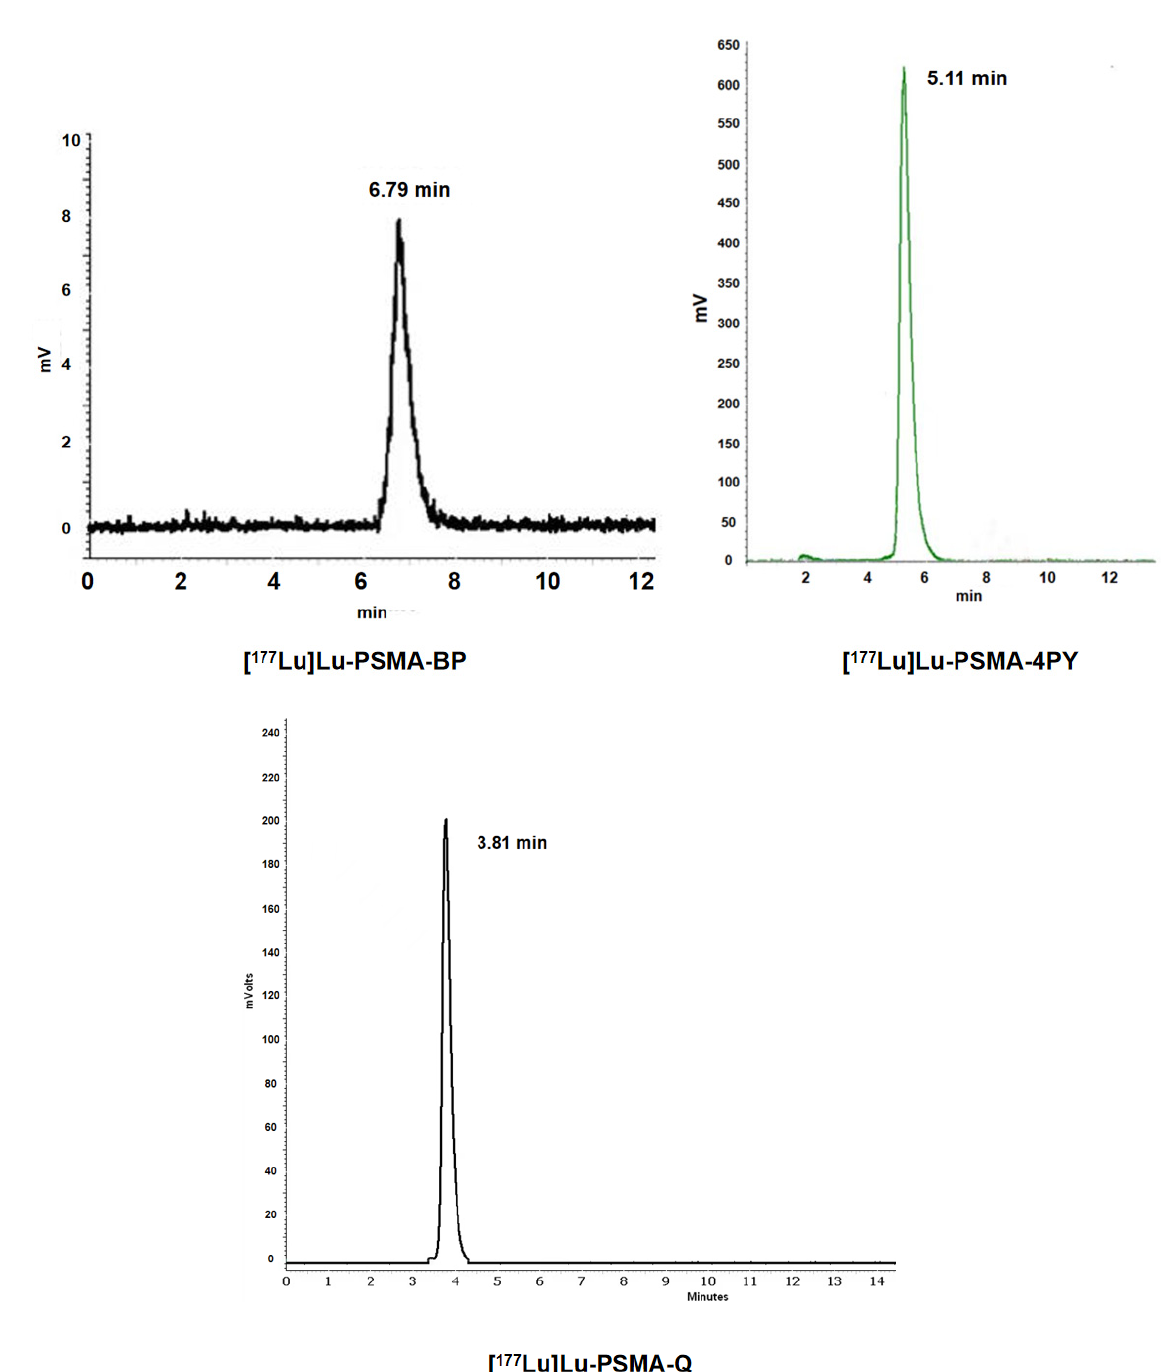
Figure 1. Integration diagram of analytical HPLC radioactive traces of [ 177 Lu]Lu-PSMA-BP [29], [ 177 Lu]Lu-PSMA-4PY and [ 177 Lu]Lu-PSMA-Q. Mobile phase was 25% acetonitrile mixed with 0.4% phosphoric acid.